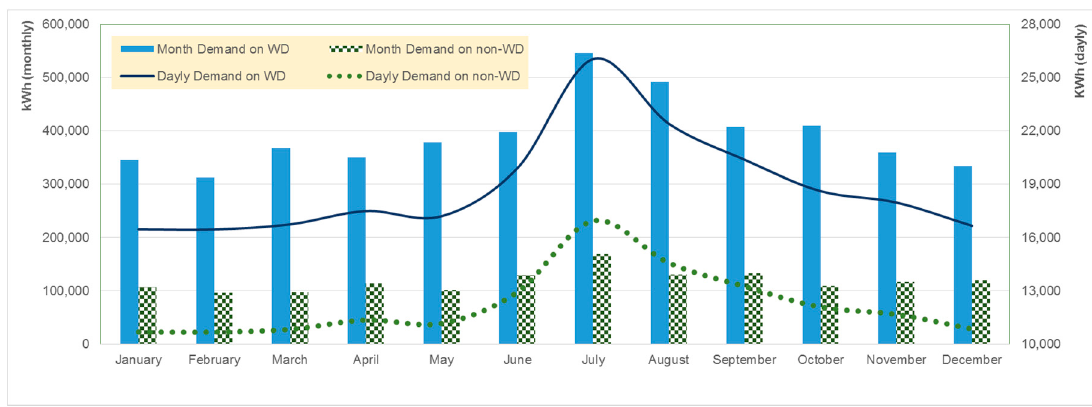
Figure 3. Monthly and daily demands performed on the Sec SS 3.